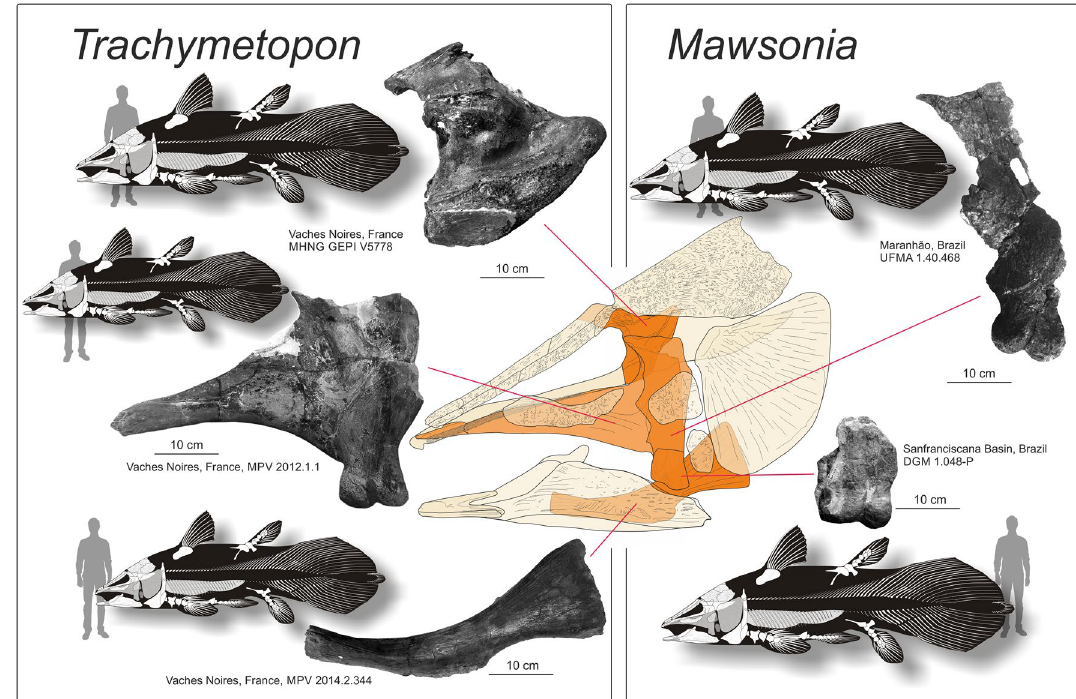
Figure 5. Fragmentary elements from the giant specimens of the Jurassic Trachymetopon and the Cretaceous Mawsonia . Human silhouettes corresponds to 1.8